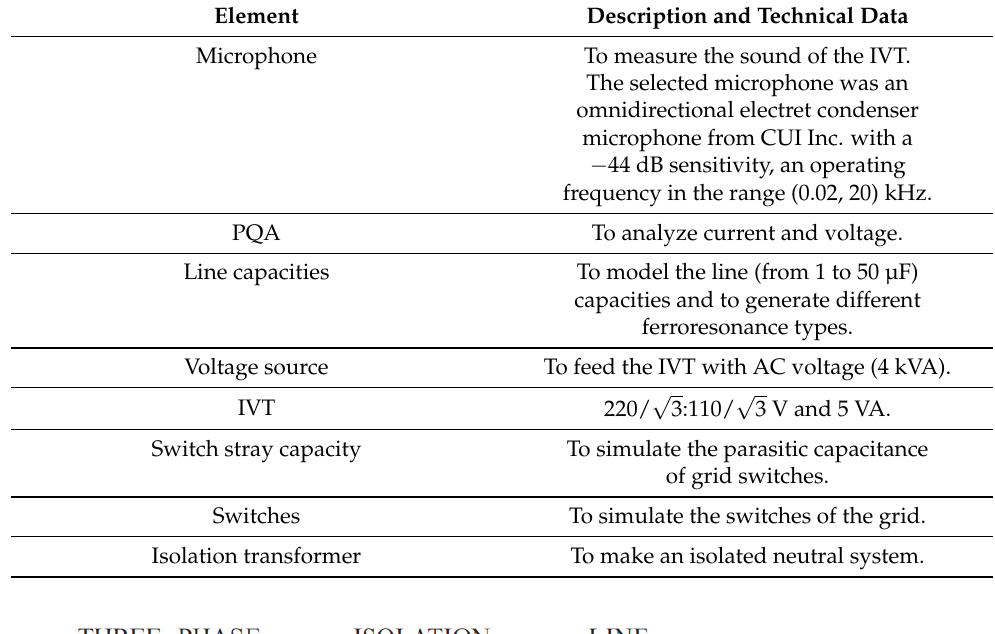
Table 3. List of main elements of the system.